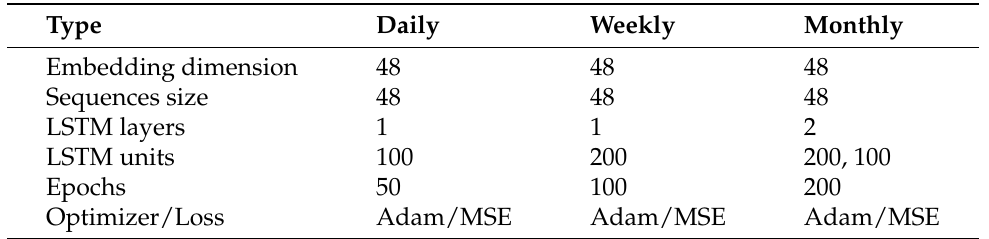
Table 3. The proposed E XPECT prediction model